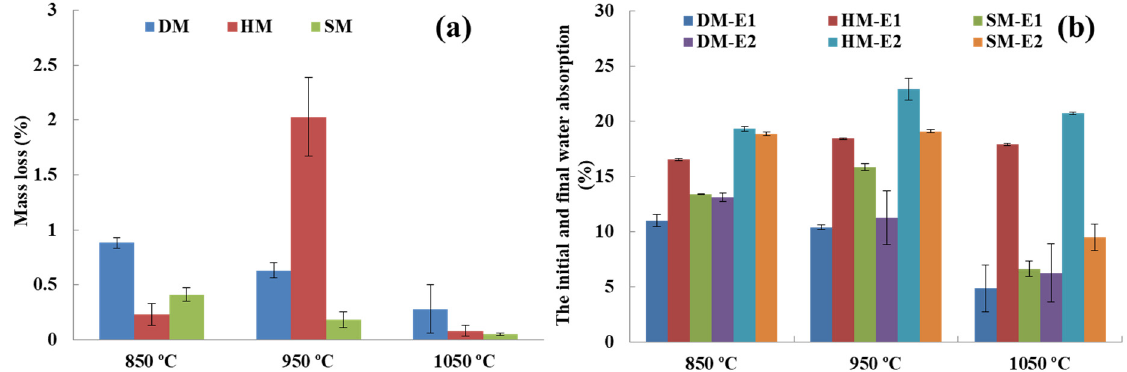
Figure 14. Freeze–Thaw Resistance after 200 cycles (a) Mass loss (%) due to freeze–thaw; ( b ) the initial and final water absorption.